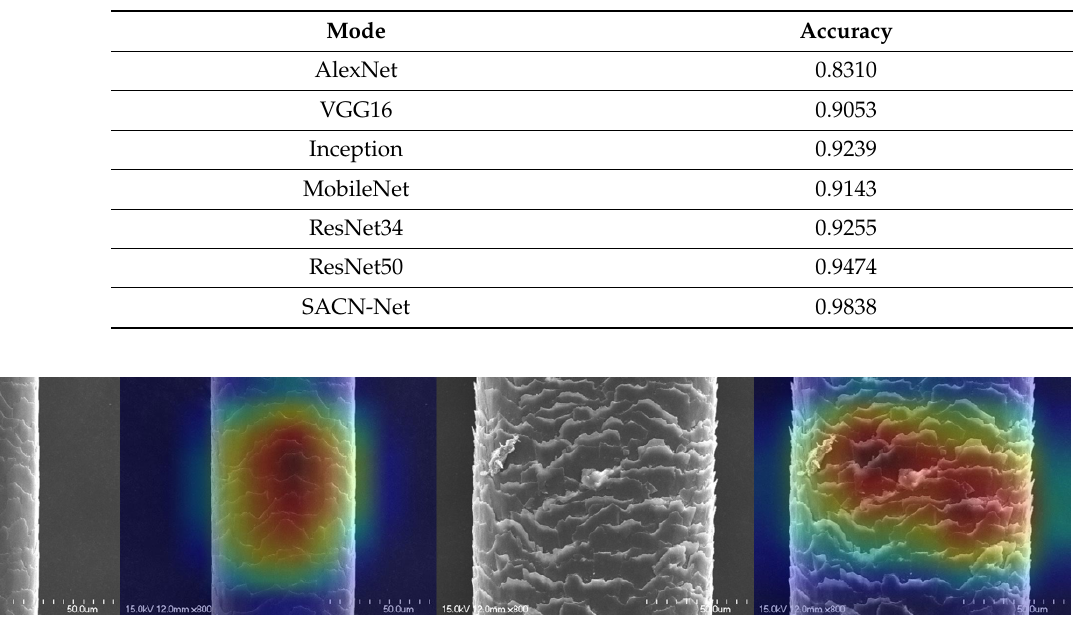
Figure 9. Attention to the feature map of hair damage area.